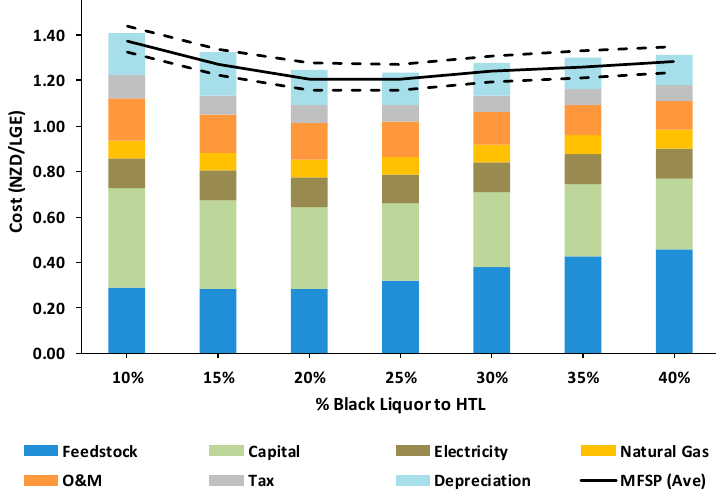
Figure 4. MFSP and the breakdown of the levelised production costs of the HTL process with different processing size.